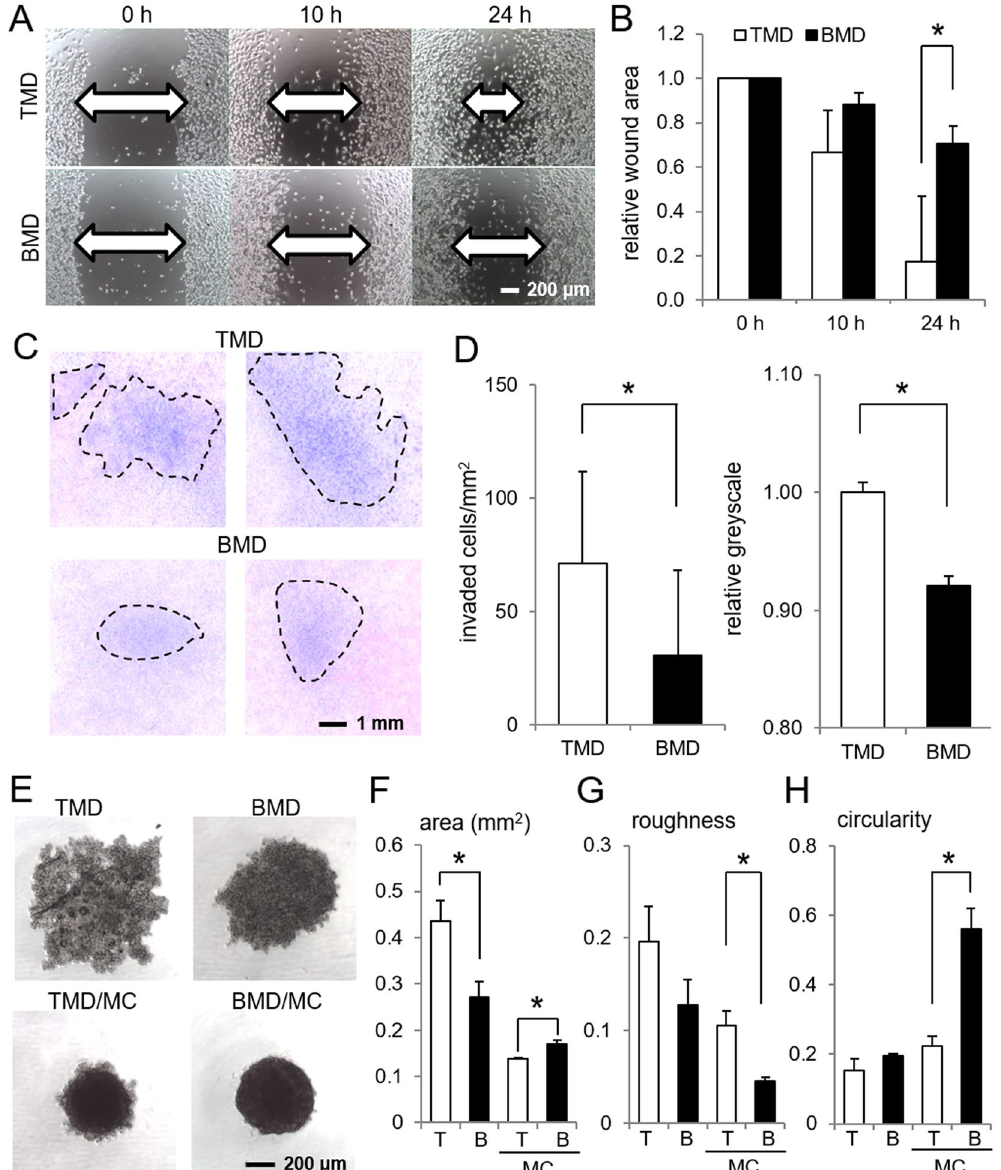
Figure 1. Phenotypic characterization of TMD cells and BMD cells. Of note, T = TMD cells, B = BMD cells, and MC = MC3T3 osteoblast-like cells. The single asterisk indicates p < 0.05. ( A , B ) Higher motility of TMD cells than BMD cells in a 2-dimensional scratch assay. ( C , D ) Higher invasion capability of TMD cells than BMD cells in a 3-dimensional invasion assay. ( E ) Spheroid formation of TMD and BMD cells with and without MC3T3 osteoblast-like cells. ( F – H ) Three spheroid parameters (area, roughness, and circularity, respectively) in TMD cells and BMD